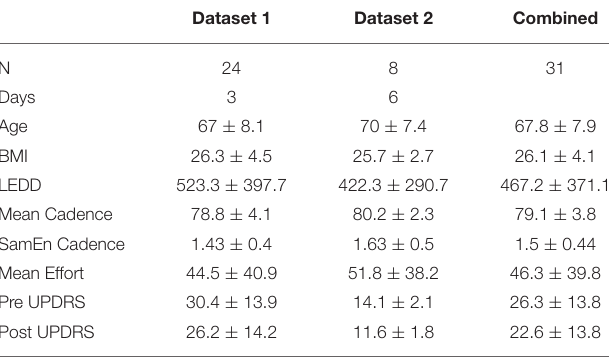
TABLE 1 | Summary of data used for the model